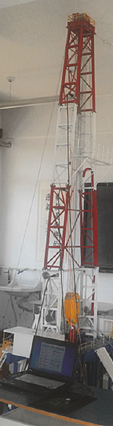
Figure 7: Laboratory model of the ZJ70-type derrick steel structure.